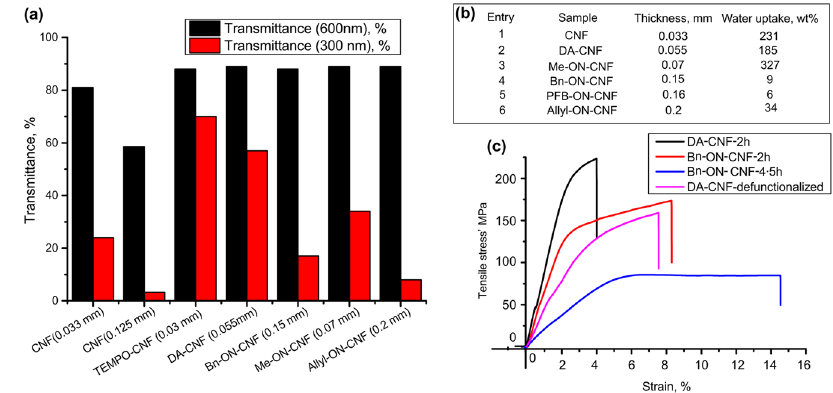
Fig.6|PropertiesofCNF,DA-CNF,andR-ON-CNF.a OpticalpropertiesofDA-CNF (3.2mmol/g of aldehyde groups) and R-ON-CNF, the transmittance at 600nm (black)and300nm(red),SupplementaryFigs.3and4. b WateruptakeofCNF,DA- CNF,andR-ON-CNF fi lms. c TensilepropertiesofDA-CNF-2h(black),Bn-ON-CNF-2h